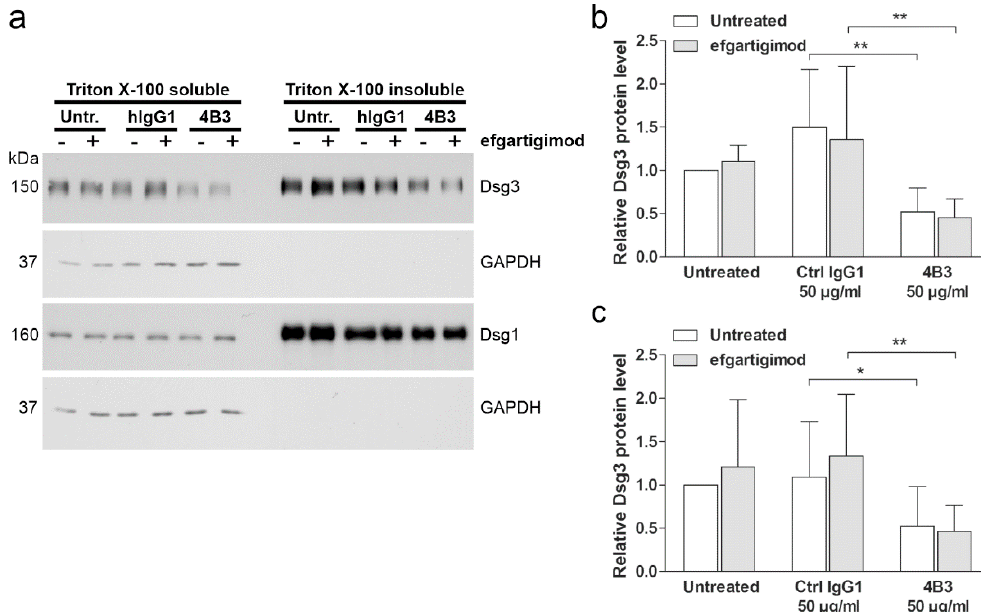
Figure 8. 4B3 antibody-induced Dsg3 depletion occurs from the non-desmosomal and desmosomal pools and cannot be rescued by efgartigimod. hTert cells were plated on 6-well plates, grown in KGM2 medium with 0.05 mM CaCl 2 until confluent, and then switched to KGM2 with 2 mM CaCl 2 for 24 h. Thereafter, the cells were either left untreated, or efgartigimod (25 µg/mL) was applied for 30 min prior to a 24 h treatment with 4B3 (50 µg/mL) antibodies. As controls, mock incubation (untreated) and an isotype-matched human IgG1 (50 µg/mL) were included. Sequential detergent extraction was performed, resulting in Triton-soluble (non-desmosomal) and Triton-insoluble (desmosomal) pools of proteins. ( a ) Western blot analysis of the fractions was performed to detect Dsg3 and Dsg1. Analysis of GAPDH level was included to ensure equal loading and the purity of the detergent insoluble fraction. Equal percentage of each fraction was loaded. Western blot signals for Dsg3 in the non-desmosomal ( b ) and desmosomal ( c ) pools were quantified using ImageJ software, normalized against GAPDH levels, and expressed as relative amounts compared to the untreated controls. The error bars represent the SD of four independent experiments. Statistical analysis was done using two-way ANOVA with Bonferroni’s post-test. Statistically significant differences are indicated by * = p ≤ 0.05, ** = p < 0.01.